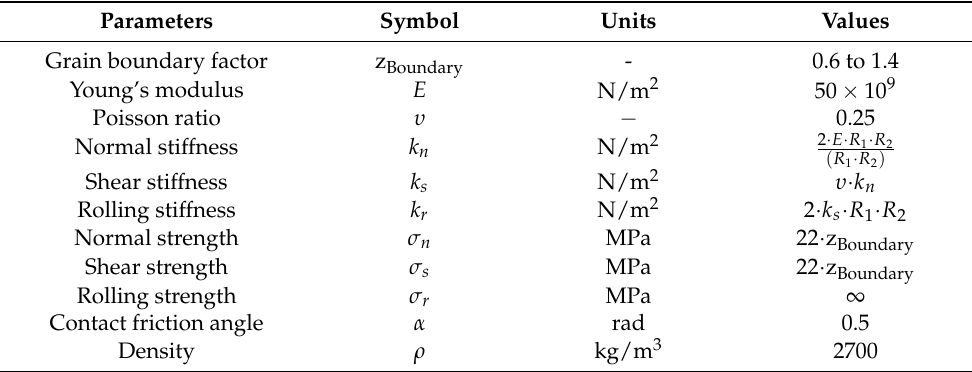
Table 3. Parameters for the bonding of two discrete elements of radii R 1 and R 2